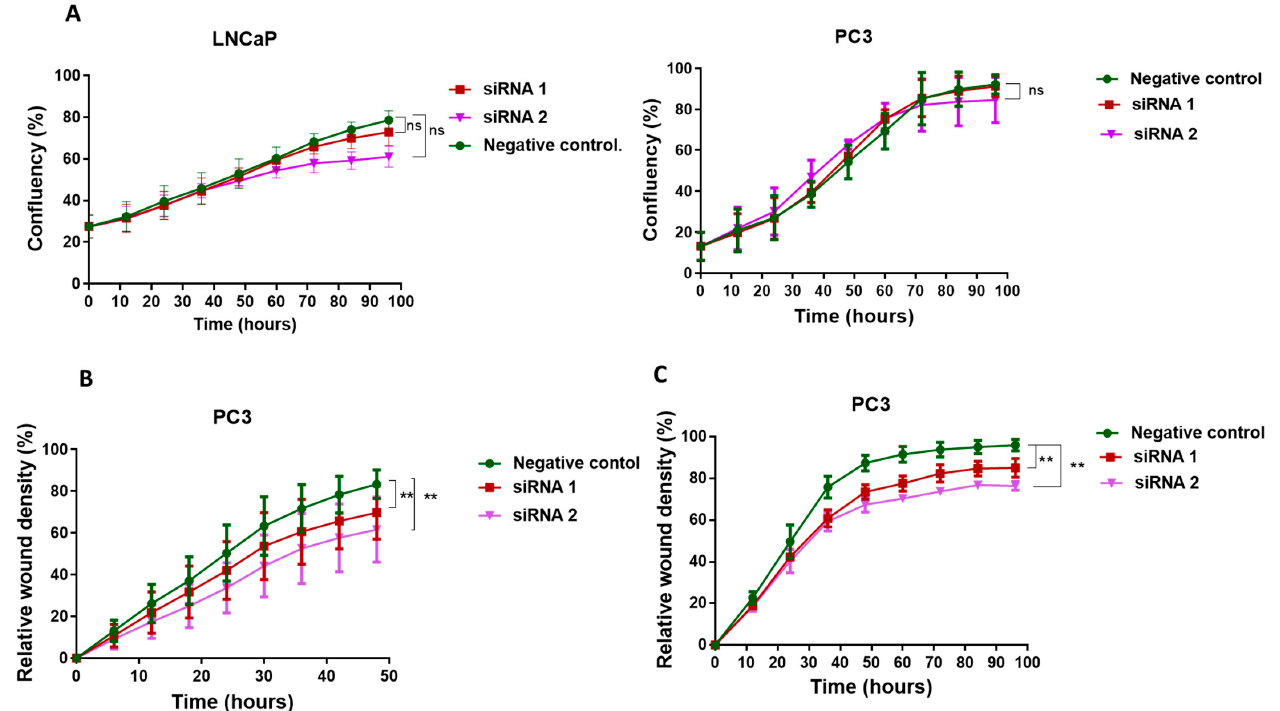
Figure 2. PDK1-mediated proliferation, migration and invasion of prostate cancer cells. ( A ) PDK1 knockdown did not exert a significant effect on prostate cancer cell (LNCaP and PC3) proliferation as measured by the IncuCyte cell imaging system. ( B ) Suppression of PDK1 reduced migration of PC3 cells. PC3 cells were grown to confluence, and a wound was created using a 96-well wound maker, and images were recorded over 2 days. The percentage of cells that migrated through the wound was plotted as relative wound density in non-targeting siRNA control vs. PDK1 knockdown cells. ( C ) PC3 cells with PDK1 knockdown showed a reduction in the invasion. Cells were layered onto Matrigel-coated plates, and a wound was created as above. The percentage of cells that invaded through the wound was plotted as relative wound density in negative control vs. PDK1 knockdown cells. Statistically significant differences were assessed using a one-way ANOVA with Tukey’s multiple comparison test; Mean ± SEM, n = 3, ** p < 0.01.